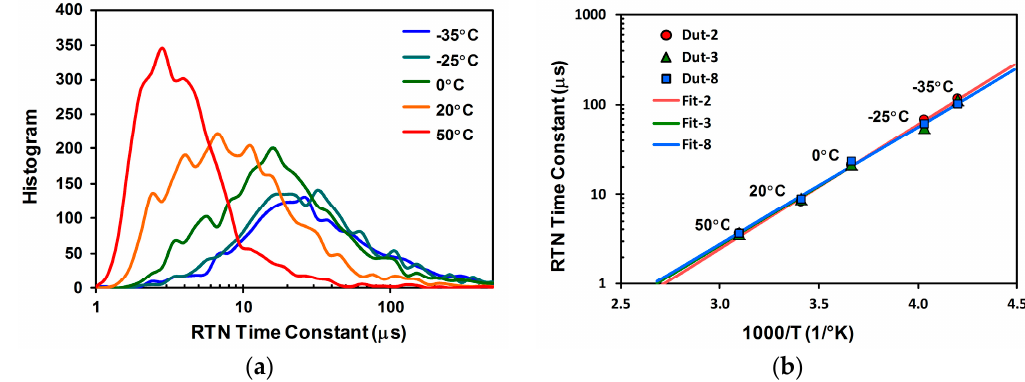
Figure 20. ( a ) The distributions of the RTN characteristic time constants at different temperatures. The RTN time constants are extracted from the 1000 noisiest pixels of 3 samples; ( b ) The Arrhenius plots of the medians of the RTN time constants for 3 samples.